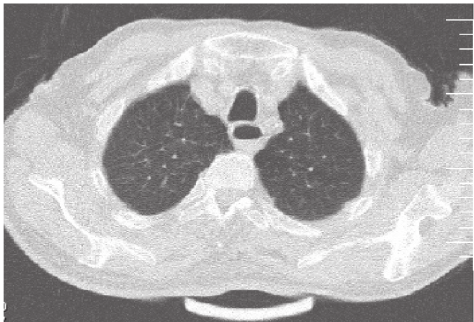
Figure 3: Male patient’s abdominal CT (arrows: ascites).